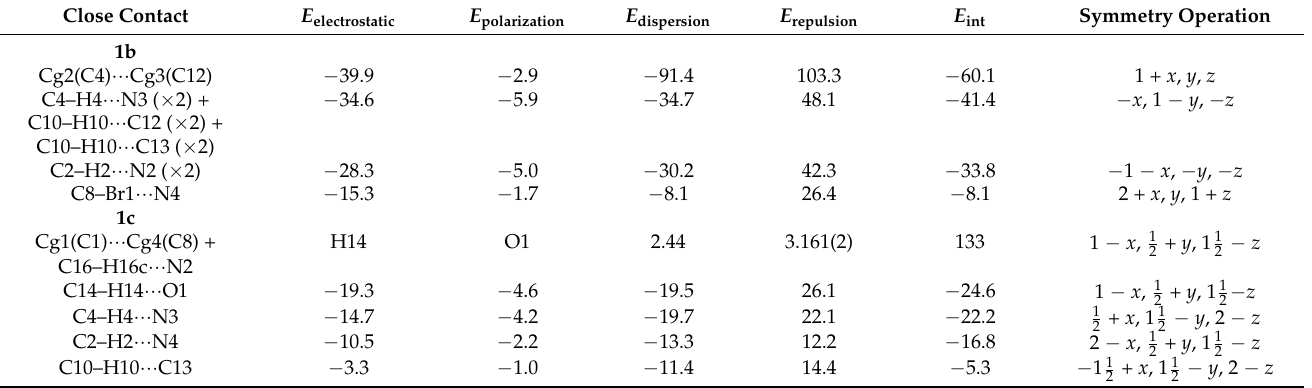
Figure 8. The calculated enrichment ratios (diamonds) greater than unity for selected contacts and their percentage distribution (bars) in ( a ) 1b and ( b ) 1c . Table 4. Interaction energies (kJ/mol) for all close contacts present in the crystals of 1b and 1c a